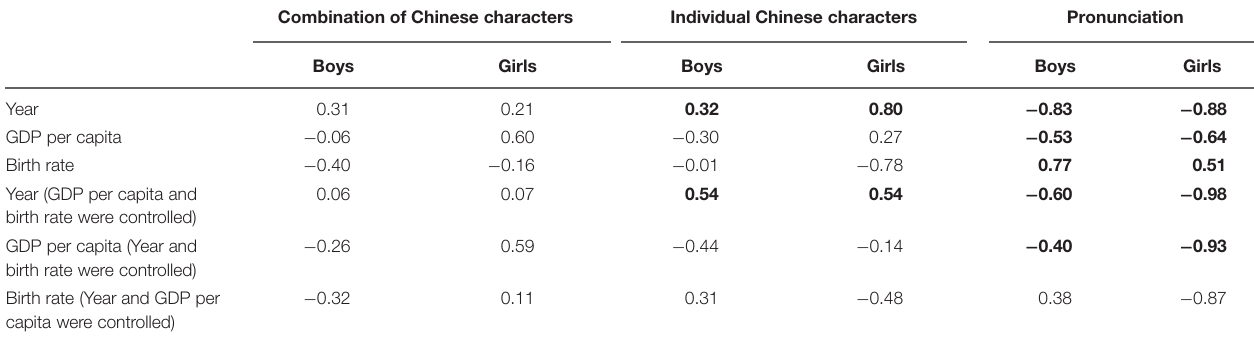
TABLE 3 | Simple and partial correlations between year, GDP per capita, birth rate, and each name index in Study 1.